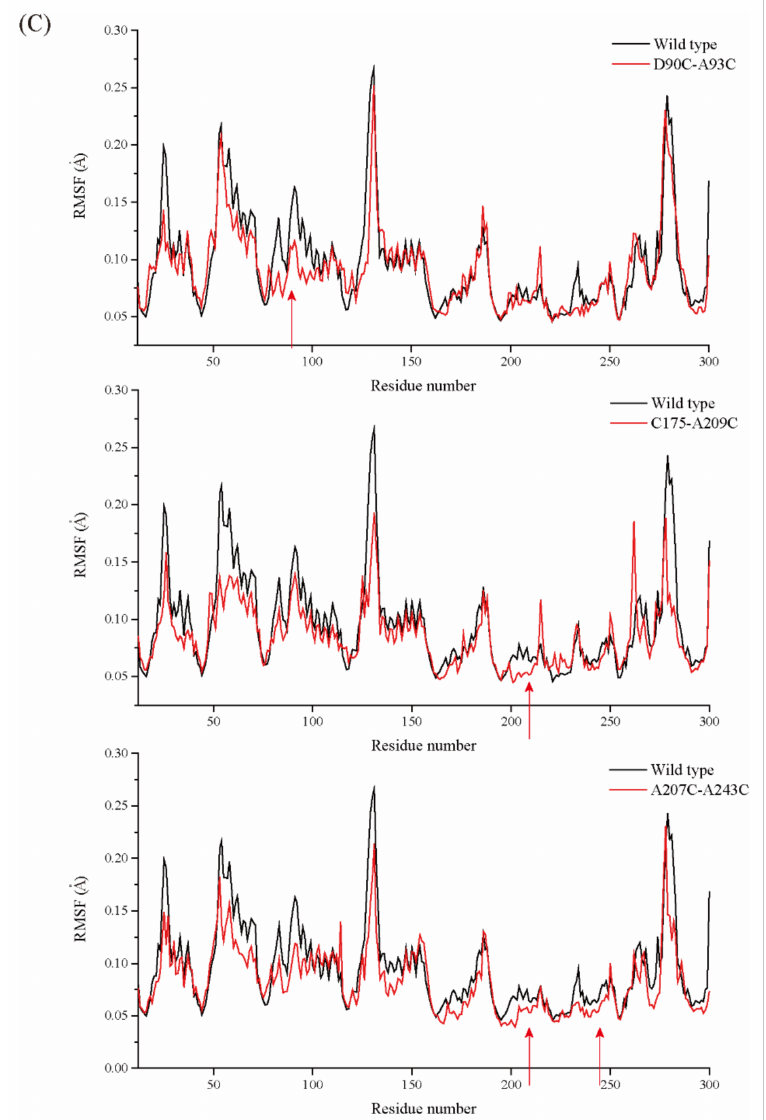
Figure 5. ( A ) RMSD values at 328 K during a 15 ns simulation for wild type DPEase and the three mutants. ( B ) Distribution of the RMSD values. ( C ) RMSF values at 328 K during a 15 ns